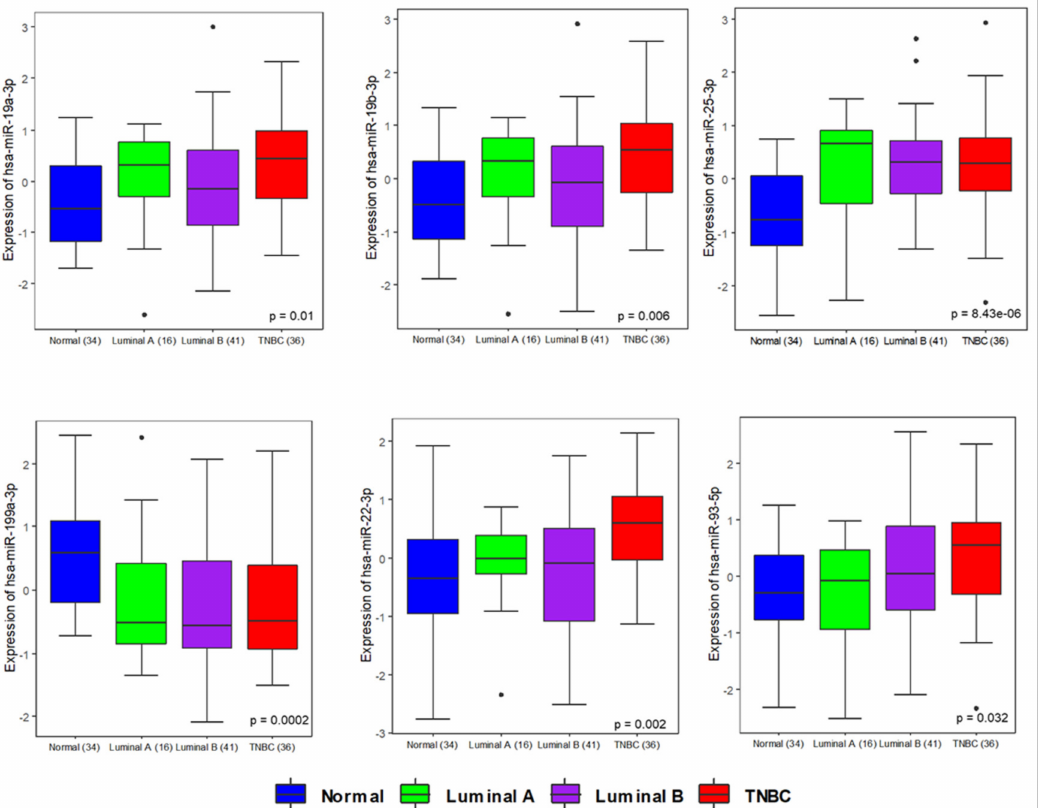
Figure 2. Expression pattern of miRNAs in different subtypes of breast cancer and normal healthy individuals. Individual boxplots show the expression pattern of miRNA smiR-19a-3p, miR-19b-3p, miR-199a-3p, miR-25-3p, miR-22-3p, and miR-93-5p across normal, luminal A, luminal B, and TNBC samples profiled in this study. Significant ANOVA-based p -values are